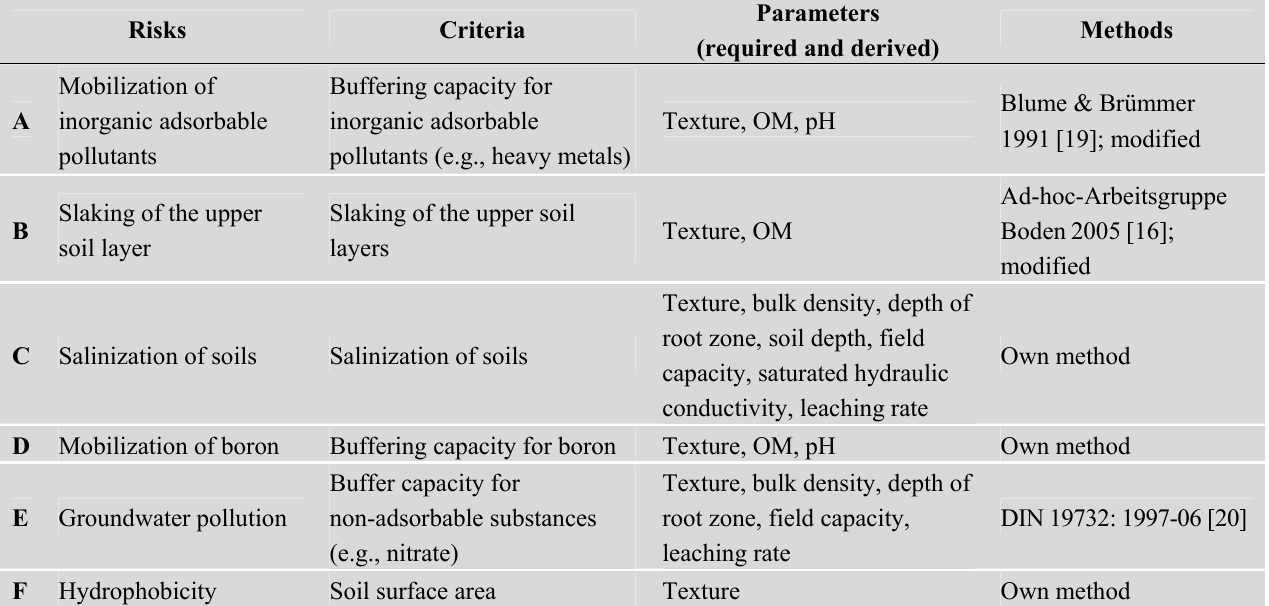
Table 1. Overview of the defined risks, criteria, methods and the parameters used.